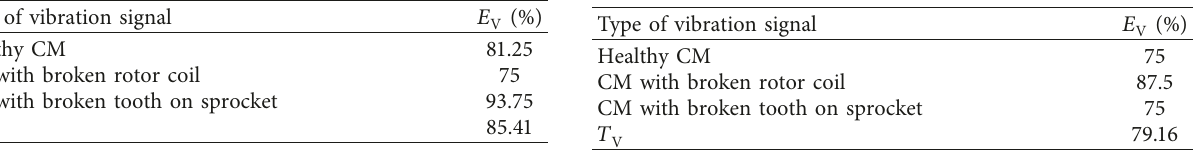
Table 7: The results of recognition of vibration signals—the MSAF- RATIO-50-SFC-EXPANDED and the LDA classifier were used.